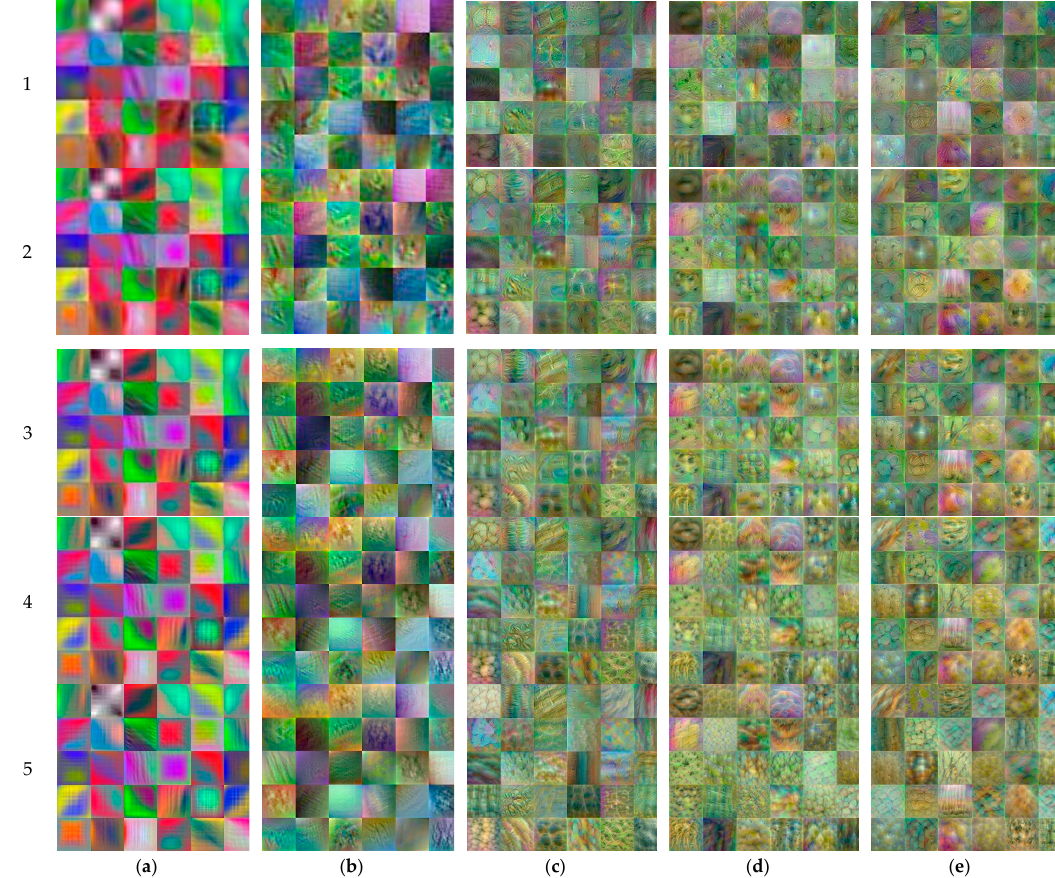
Figure 11. The first 30 features learned by the five convolutional layers of the proposed classifier (Leftmost column: PyramidLevels values): ( a ) Conv1; ( b ) Conv2; ( c ) Conv3; ( d ) Conv4; ( e ) Conv5.